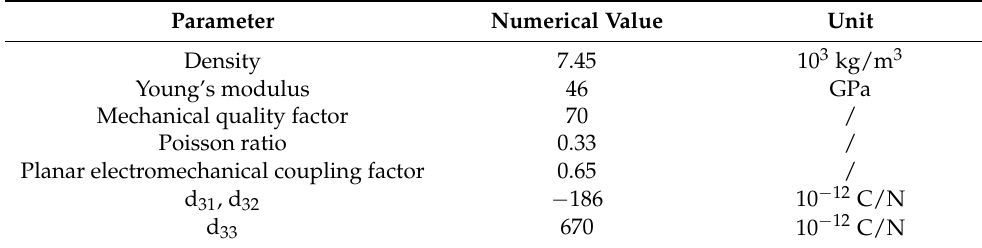
Table 1. Performance parameters of PZT-5H.